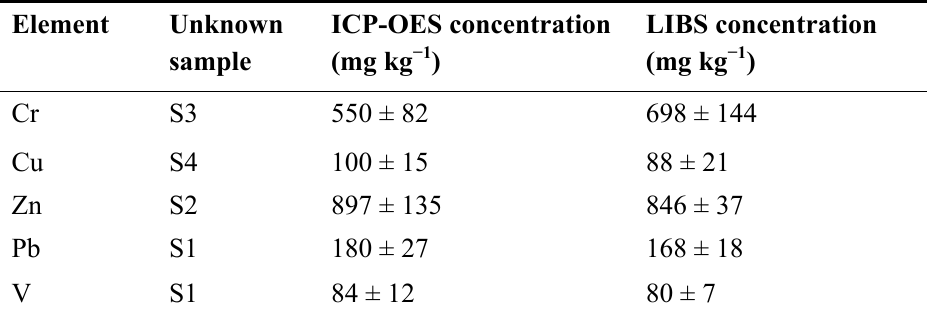
Table 2. Comparison between concentrations of heavy metals in soil samples determined by ICP-OES and by LIBS (calibration line method).